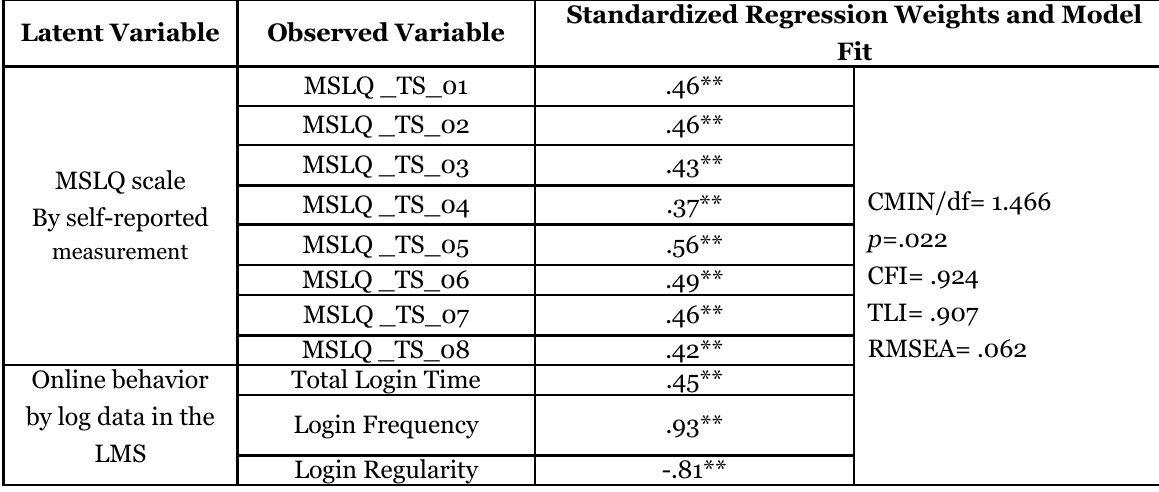
Table 3 Standardized Regression Weights of the Measurement Model Latent